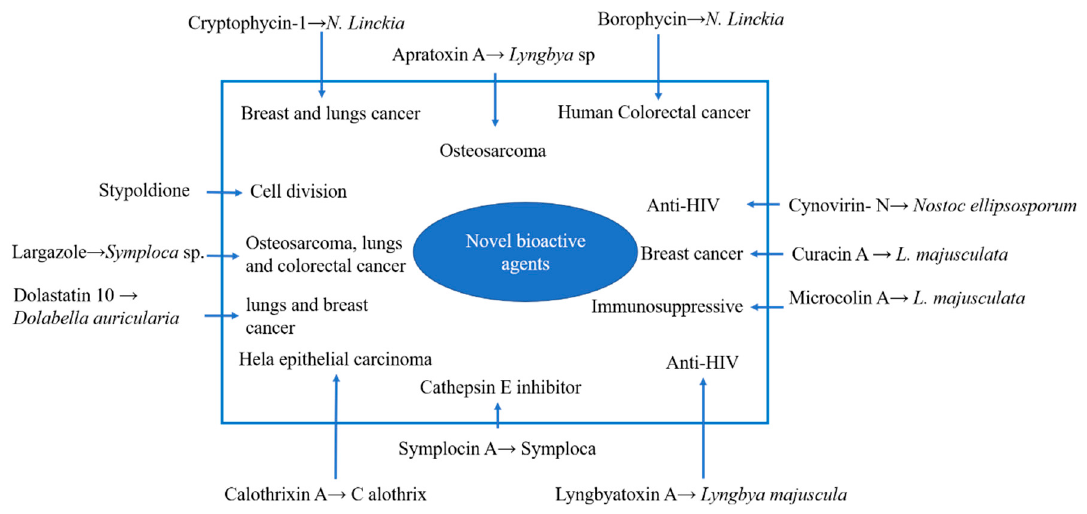
Figure 2. Novel bioactive agents from cyanobacteria and their potential effects.